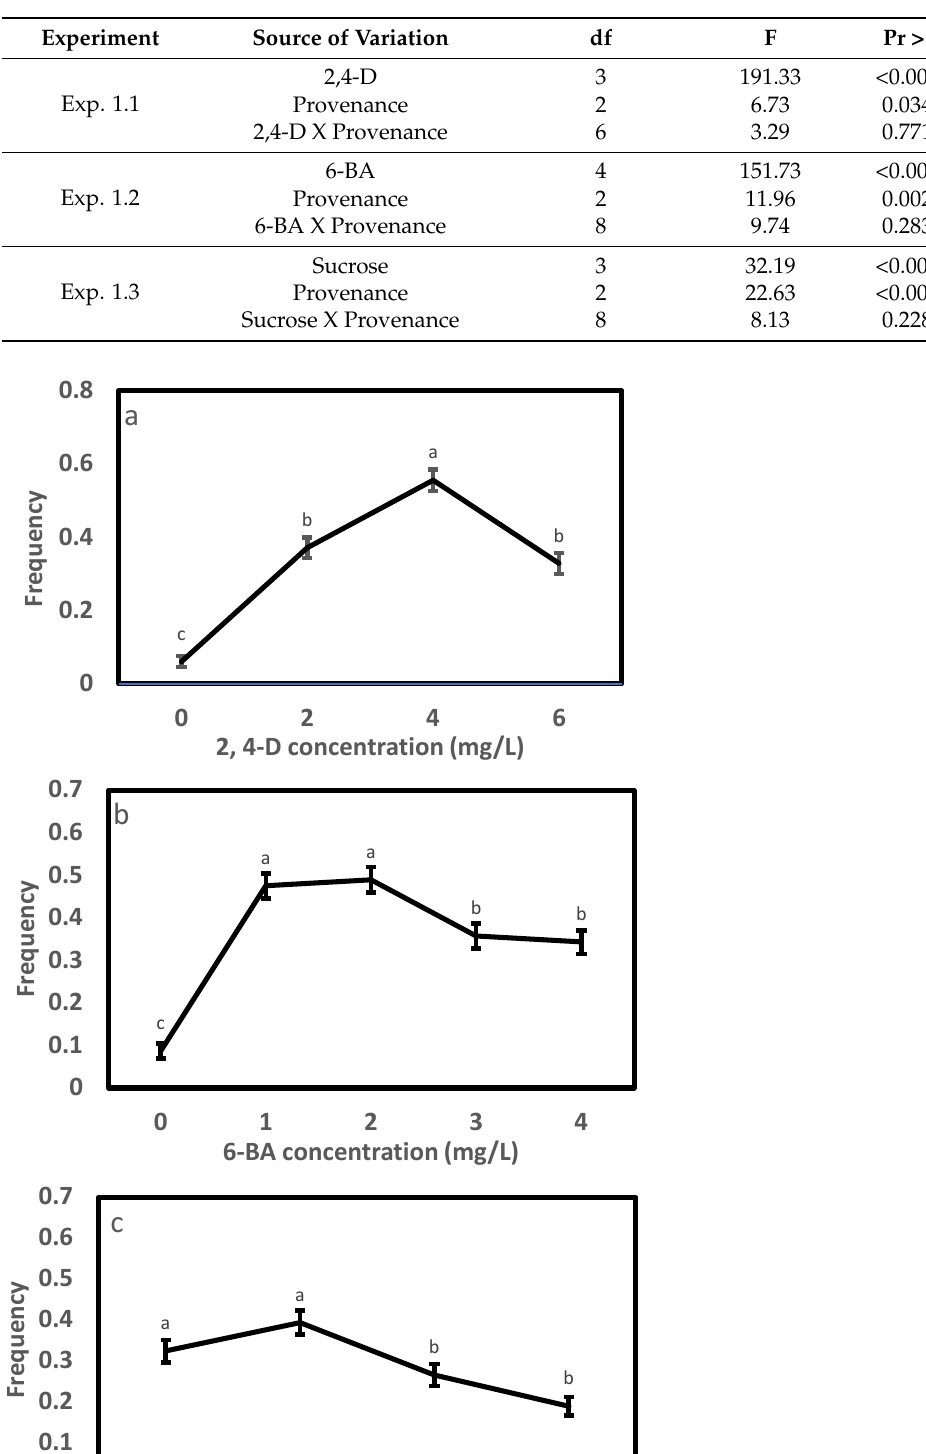
Table 2. Results of analysis of variance in Picea pungens somatic embryogenesis initiation experiments.